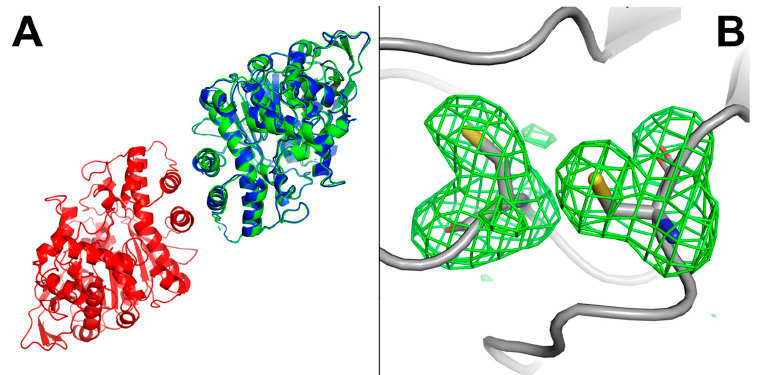
Figure 6. Structure of hBChE-7. ( A ) cartoon representation of the in cristallo dimer form of hBChE-7 (PDB ID 6EMI) as red and blue chains. Superposition of the structure of recombinant hBChE from CHO cells (PDB ID 1P0I), green chain; ( B ) representation of the broken Cys65-Cys92 disulfide bond in chain B. Protein backbone is represented in gray. Residues Cys65 and Cys92 are represented as sticks with carbon atoms in gray, oxygen atoms in red, nitrogen atoms in blue and sulfide atoms in yellow. An | F o − F c | electron density map calculated by omitting residues Cys65 and Cys92 from the model is represented as a green mesh with a 3.0 σ contour.